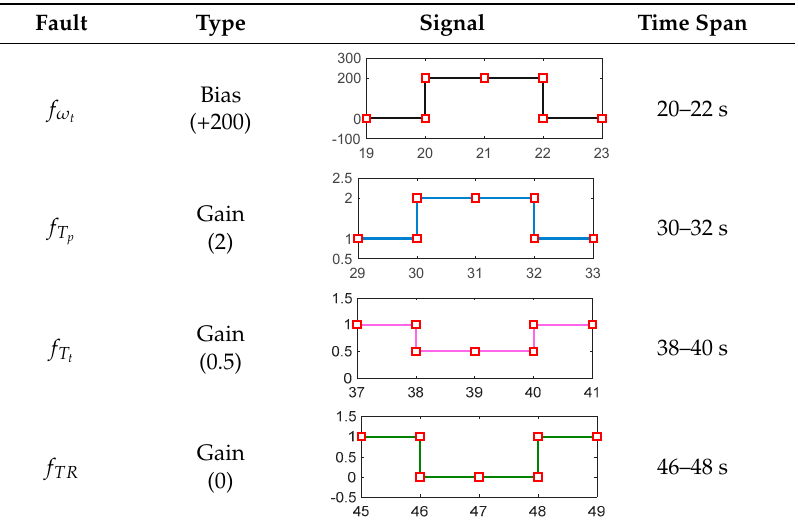
Table 6. Summary of detecting the results of the five residuals by the proposed FDI system.